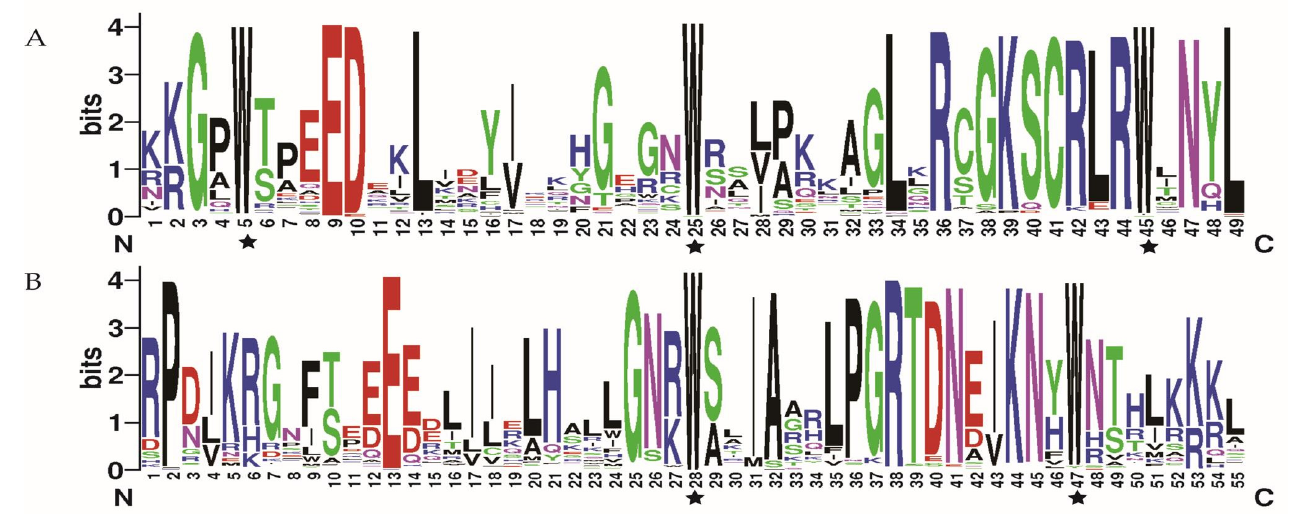
Figure 2 . R2 and R3 MYB repeats of R2R3-MYBs are highly conserved in Rhododendron delavayi . R2 ( A ) and R3 ( B ) MYB repeat sequences were based on multiple alignment analysis of the R2R3-MYB structural domain of all R. delavayi . Bits indicate the relative frequency of amino acids. Asterisks indicate conserved Trp residues in the MYB domain. The amino acids are arranged from the N terminal to the C terminal.